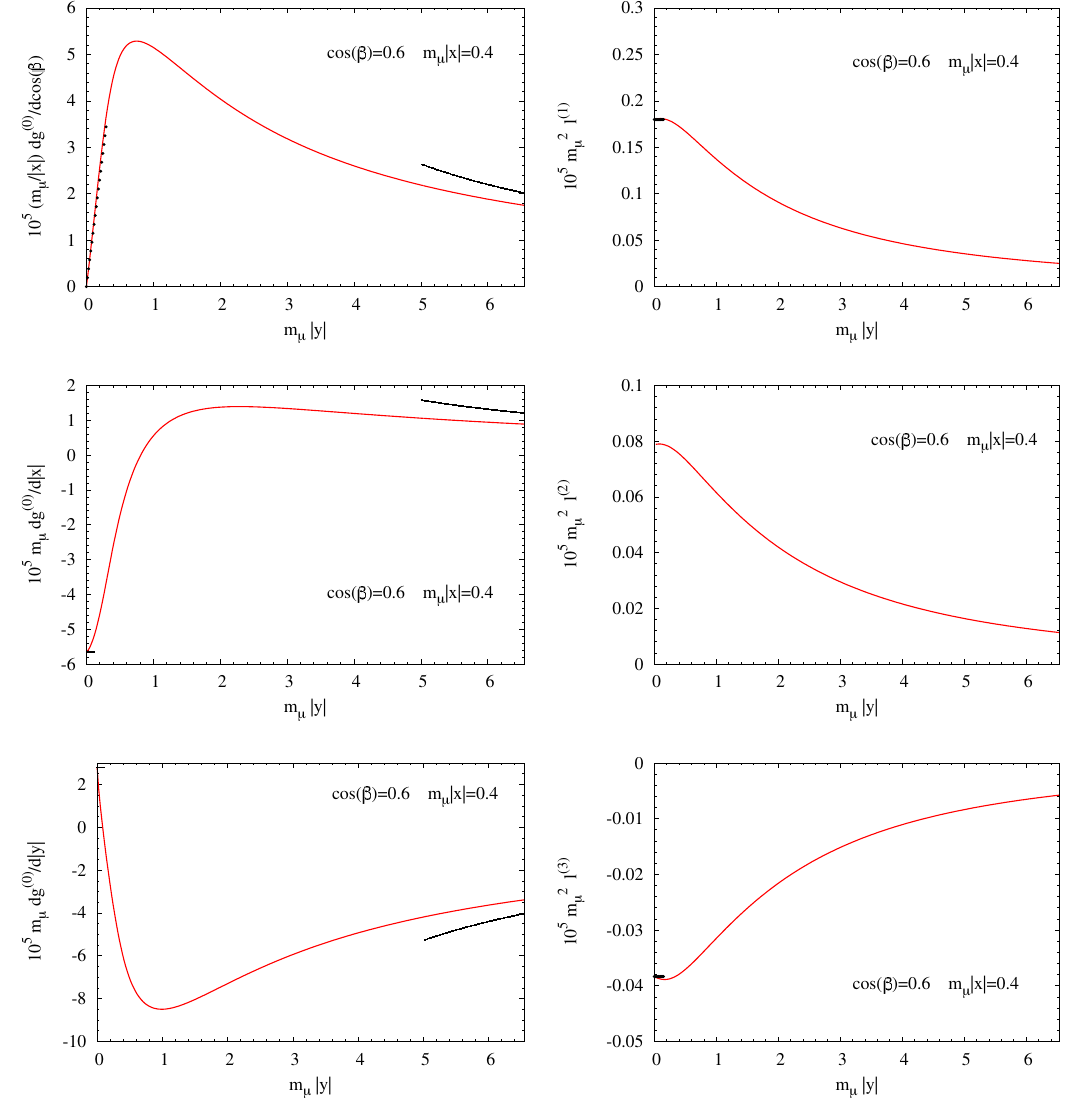
Figure 4 . Left panels: the derivatives of the scalar weight function ¯ g (0) appearing in the QED kernel for given values of | x | and cos β ≡ ˆ x · ˆ y . The analytic predictions for the large- y asymptotics are displayed as thick solid lines. Right panels: the three tensor weight functions ¯ l (1) , ¯ l (2) , ¯ l (3) . The leading term of the Taylor expansion around the origin, which is O ( | y | 0 ) except for the top left panel, is indicated for all cases but ¯ l (2) ; note that the latter weight function is multiplied by a tensor of order | y | 2 in the QED